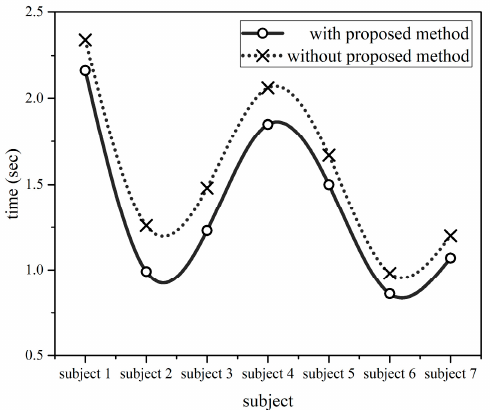
Figure 11. Comparison of the average interaction latency (with/without the proposed method) for each subject.